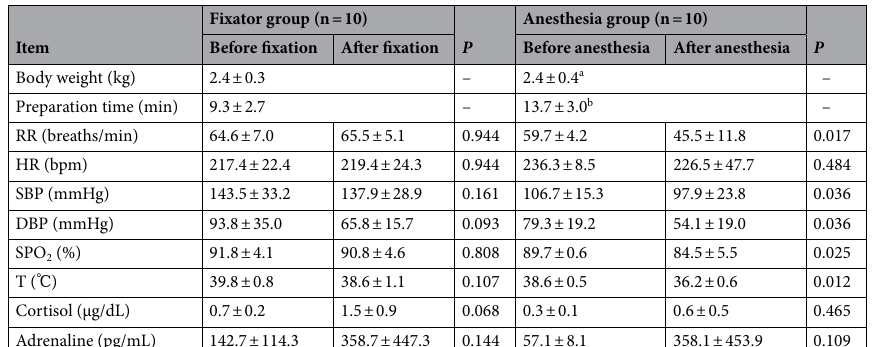
− x ± s ). RR: Respiration rate; HR: Heart rate;